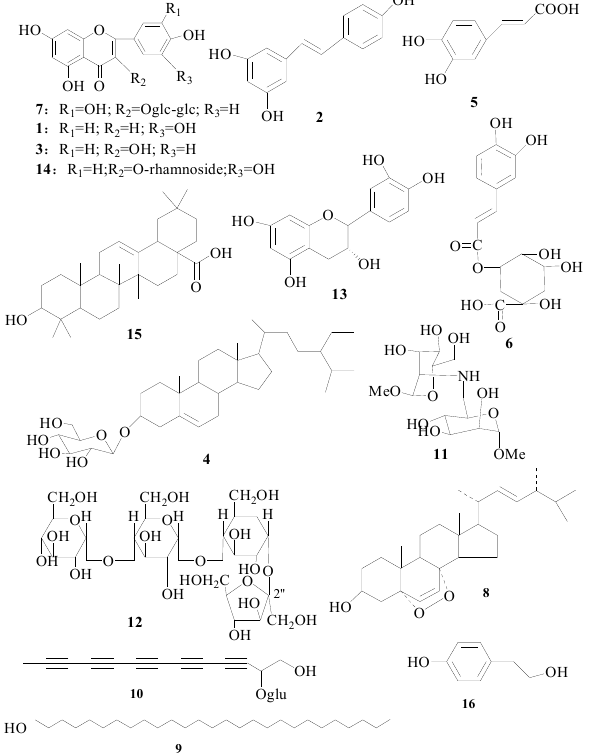
Figure 1. Chemical structures of the 16 identified compounds in F. esculentum pollens.